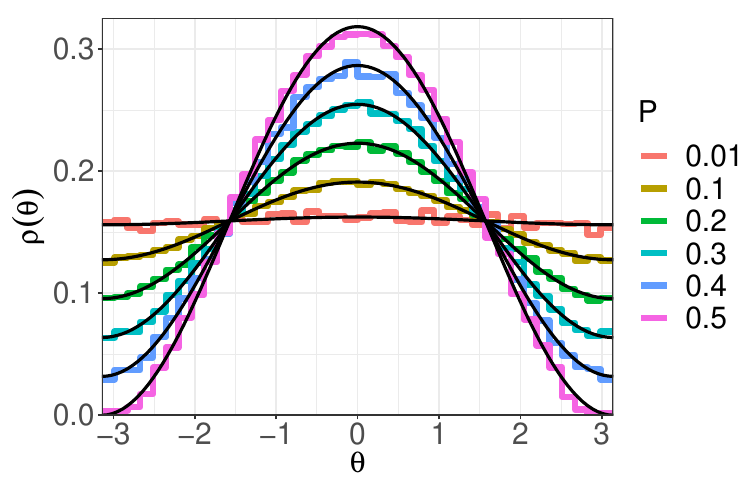
Figure 15. Distribution of Polyakov loop eigenvalues compared to the partial decon(cid:12)nement prediction (black lines) for di(cid:11)erent P values, where (cid:26) P ( (cid:18) ) is de(cid:12)ned in eq. (4.1). The Polyakov loop eigenvalues are binned around the indicated value of P with width 0 :